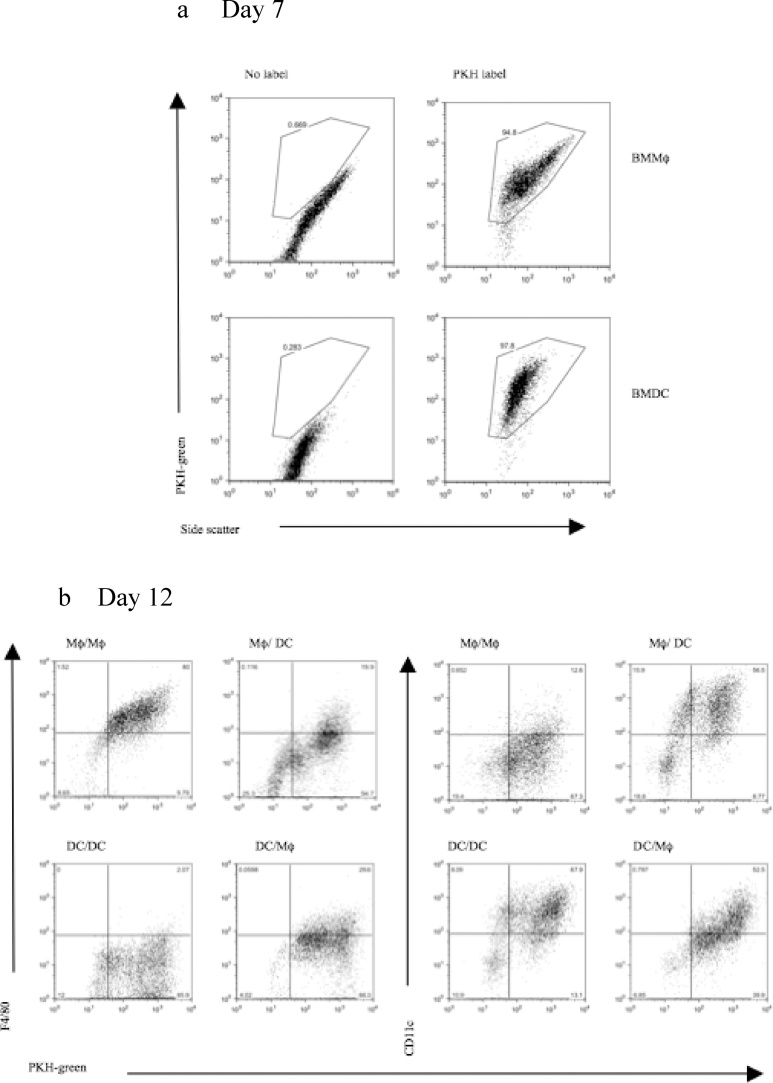
The phenotypic shifts of bone marrow-derived macrophages and dendritic cells are due to whole cell population changes and not to an outgrowth of progenitor cells. Day 7 bone marrow derived macrophages (BMMφ) or dendritic cells (BMDC) were labeled with PKH green. Flow cytometry was carried out to confirm that all cells were labeled with PKH dye (a). The labeled Mφ and DCs were then replated and cultured in either the same medium (control Mφ/Mφ and DC/DC) or switched to the opposite medium (Mφ/DC and DC/Mφ) for a further 5 days. At day 12 cells were analysed by flow cytometry to assess the expression of F4/80 and CD11c (y-axis) and the presence of PKH green (x-axis) (b).